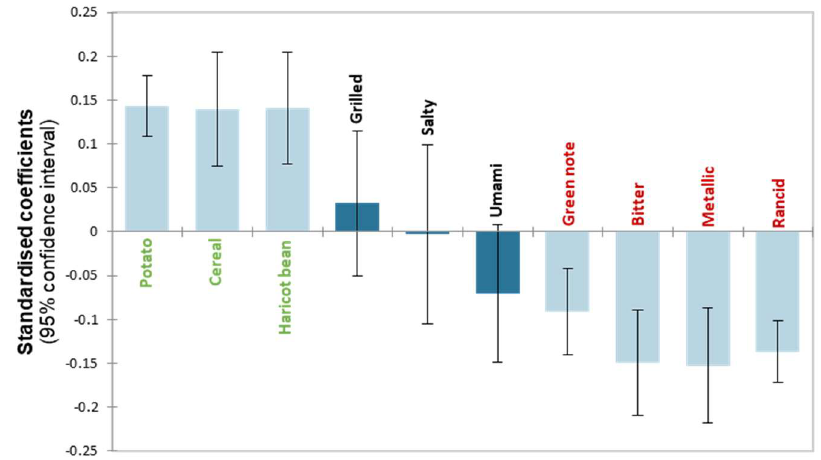
Figure 4. 95% Jack-knife confidence intervals of the descriptor coefficients in the PLS regression (one significant PLS component). The coefficients in black were not significant; those in green contributed positively to the hedonic score, whereas those in red contributed negatively.